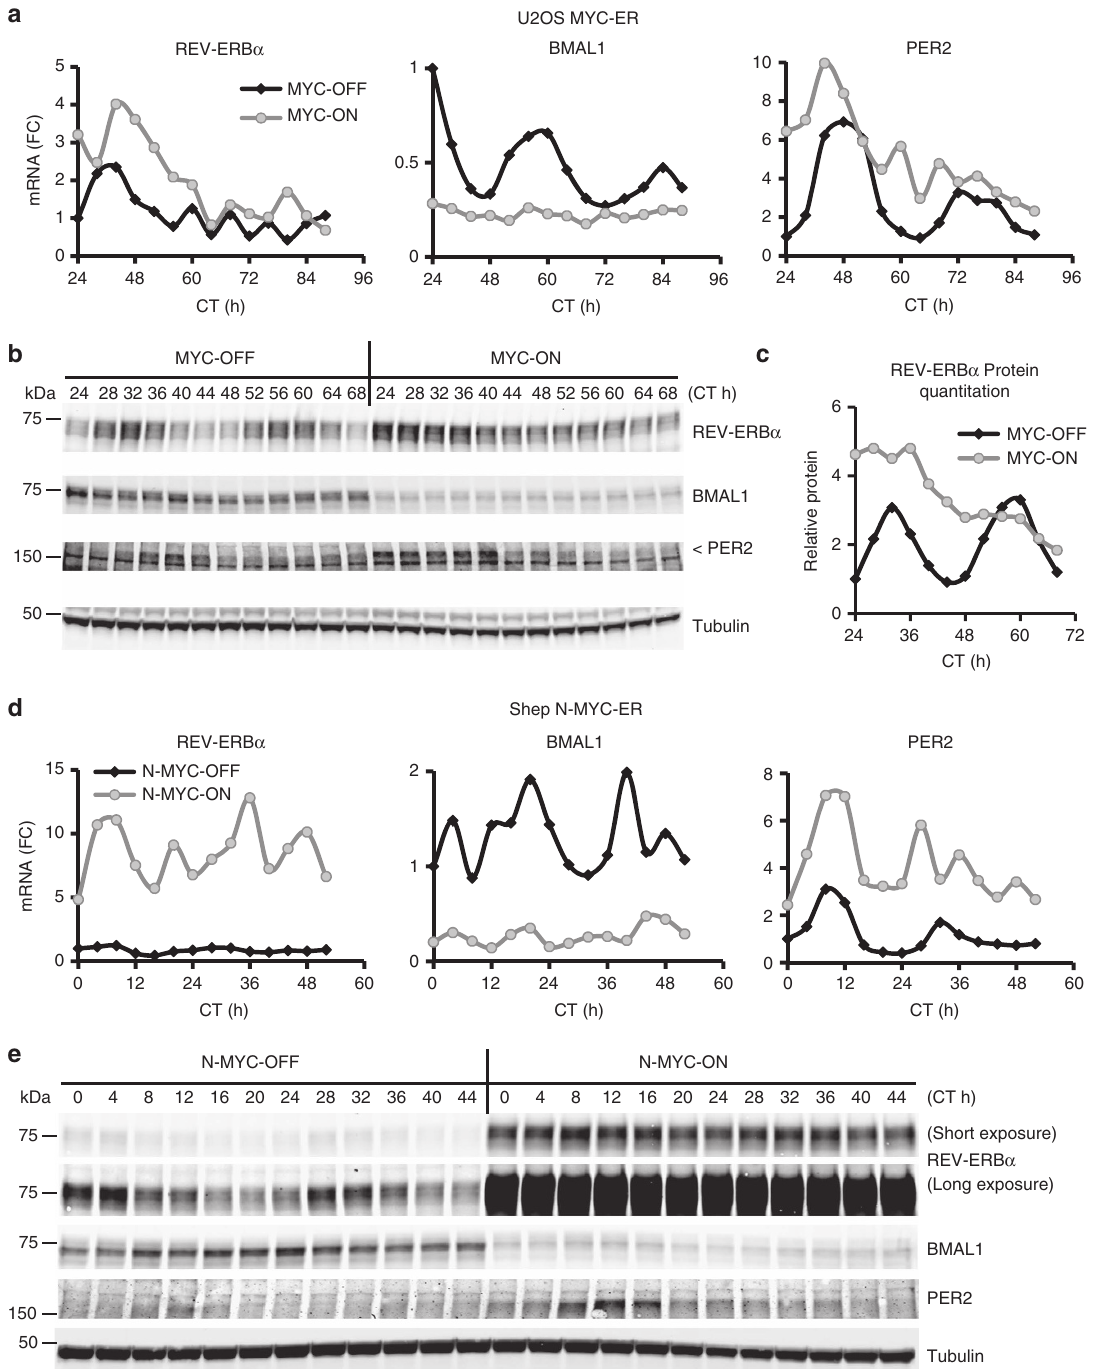
Figure 1 | MYC and N-MYC induce persistent elevation of REV-ERB a mRNA and protein. ( a , b ) U2OS BMAL1::Luc cells expressing MYC-ER were cultured ± 4OHT (with ethanol serving as a loading control for all experiments) for 24h, then changed to ‘lumicycle’ media (see Methods) ± 4OHT and þ 0.1 m M dexamethasone. ( a ) mRNA was collected at the indicated time points after synchronization, and endogenous REV-ERB a ( NR1D1 ), BMAL1 ( ARNTL ), and PER2 were determined by RT-PCR, normalized to b 2M. mRNA (FC) ¼ fold change. ( b ) Lysates were collected at the indicated time points after synchronization and processed for protein expression of REV-ERB a , BMAL1, and PER2 (indicated by o ). Tubulin serves as a loading control. Portions of a and b were previously published 1 , but instead labelled as 0–48h. ( c ) REV-ERB a protein from ( b ) was quantitated using Image Studio software (Licor, Lincoln, NE, USA), normalized to the relevant Tubulin and plotted over time. ( d , e ) SHEP N-MYC-ER expressing cells 10 were cultured ± 4OHT for 24h, then 0.1 m M dexamethasone was added. ( d ) mRNA was collected at the indicated time points after synchronization, and endogenous REV-ERB a ( NR1D1 ), BMAL1 ( ARNTL ) and PER2, were determined by RT-PCR, normalized to b 2M. ( e ) Lysates were collected at the indicated time points after synchronization and processed for protein expression of REV-ERB a (‘short’ and ‘long’ indicate exposure time), BMAL1 and PER2. Tubulin serves as a loading control. For all panels, CT (cell time) indicate time of collection after synchronization. For immunoblots, molecular weights are noted in kDa. Portions of a – c were previously published 1 and are reprinted with permission from